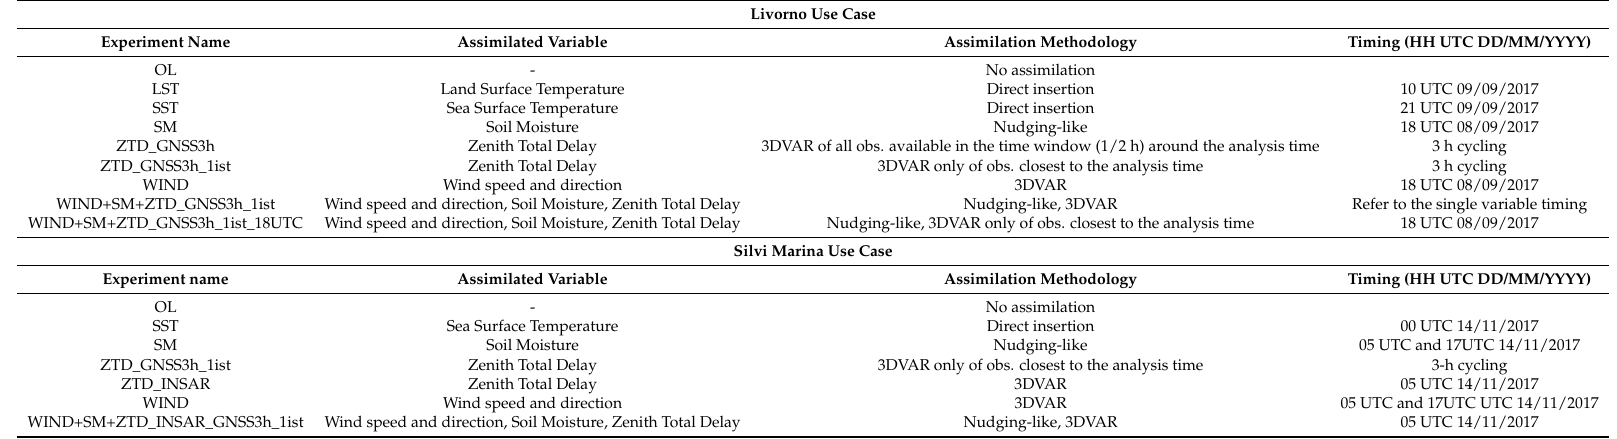
Table 3. List of experiments, timing and techniques applied for data assimilation for the Livorno and Silvi Marina use